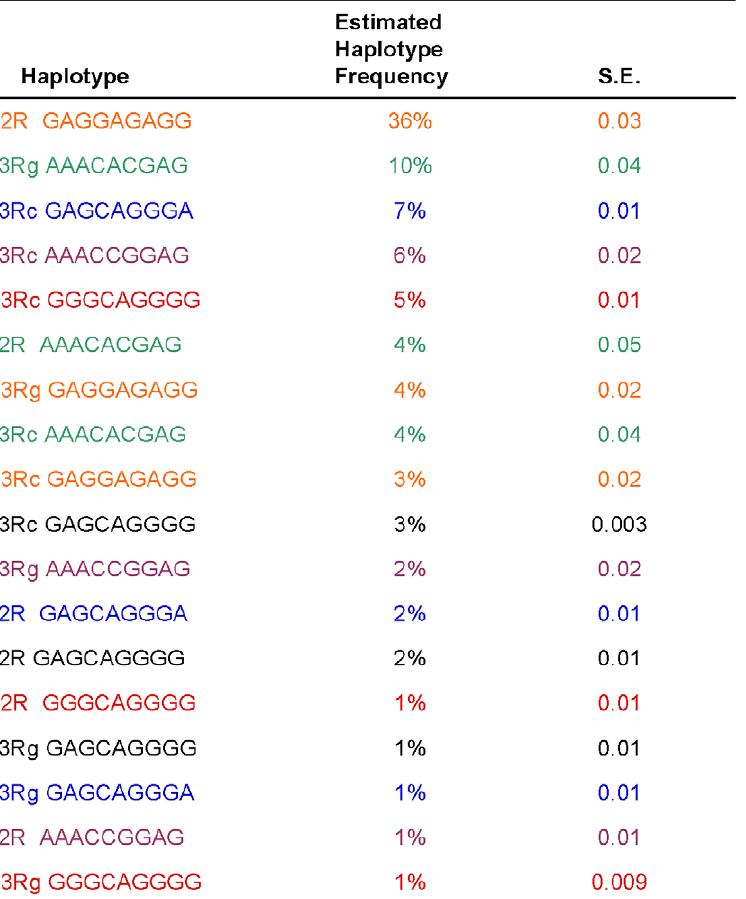
Figure 3. Estimated haplotype frequencies for common haplotype blocks ( $ 1%) containing a given VNTR type. Haplotypes that included the VNTR were estimated in 322 Caucasian patients using the following marker alleles: rs1001761, VNTR, rs699517, rs3744962, rs9948583, rs495139, rs2298582, rs2298581, rs2471186, rs7236747, and rs2612092. VNTR data was available for 31 patients. Each color represents one SNP- defined haplotype, for SNPs located in blocks 7 and 8 of Figure 1B. The observed frequency (in 31 individuals, 62 chromosomes) for each VNTR is as follows: 2R (50%), 3Rc (32%), and 3Rg (18%). The estimated haplotype frequency of association of the indicated VNTR/haplotype pair is shown and the standard error (SE) is indicated.